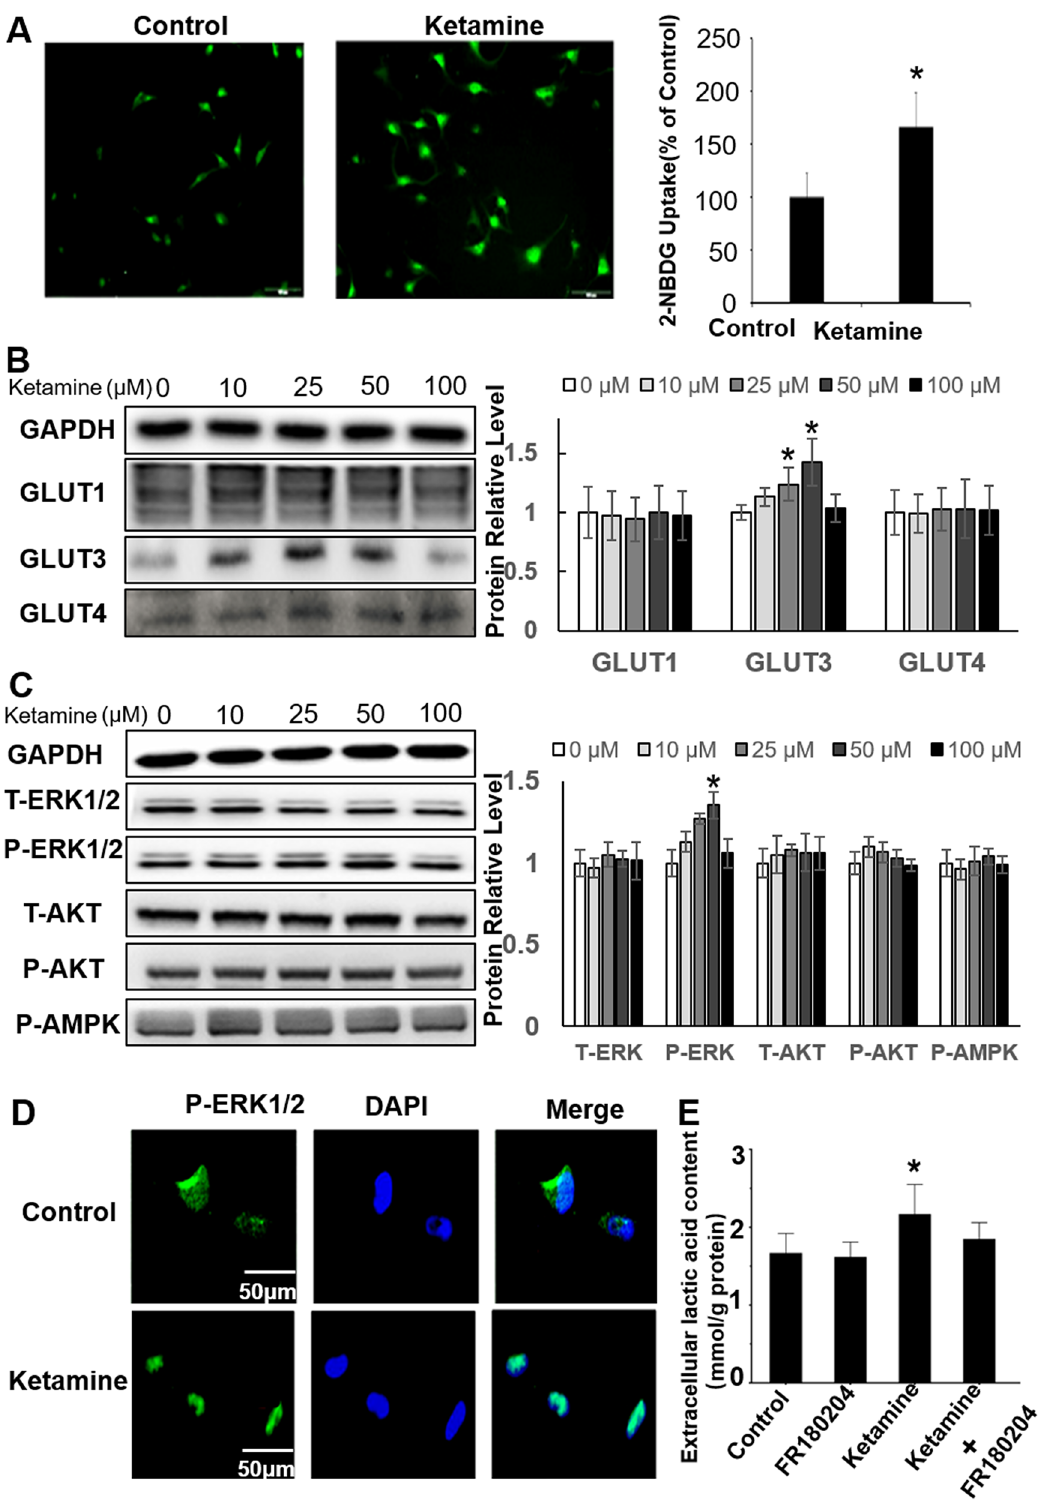
Figure 1. Ketamine increases the 2-NBDG uptake, protein levels of GLUT3 and P-ERK1/2, and production of lactate in HA1800 cells. ( A ) The intracellular fluorescence of 2-NBDG was examined by confocal microscopy. ( B ) The expression of GLUT1, GLUT3 and GLUT4 were examined by Western blots at 6 h post ketamine treatment with different concentration (0, 10, 25, 50 and 100 μM); ( C ) Western blots analysis was used to test the levels of P-ERK1/2, P-AKT and P-AMPK at 6 h post ketamine treatment with different concentration (0, 10, 25, 50 and 100 μM); ( D ) The subcellular location of P-ERK1/2 response to ketamine treatment was detected by immunofluorescent staining; ( E ) The production of lactate was tested by a lactate detection kit. Vs control, * P < 0.05 and ** P < 0.01. Immunoblotting signals were quantified via Image J